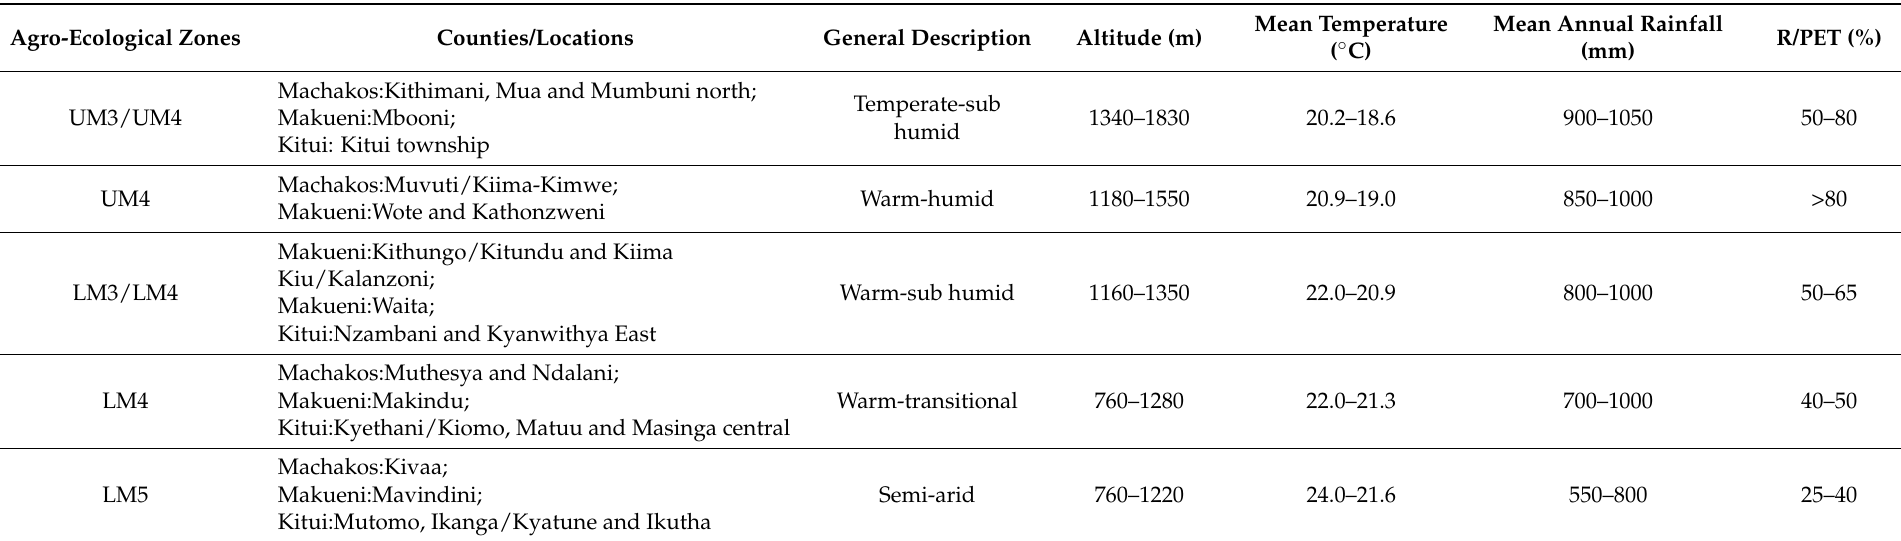
Table 1. Summary description of the agro-ecological zones in lower eastern Kenya. Agro-Ecological